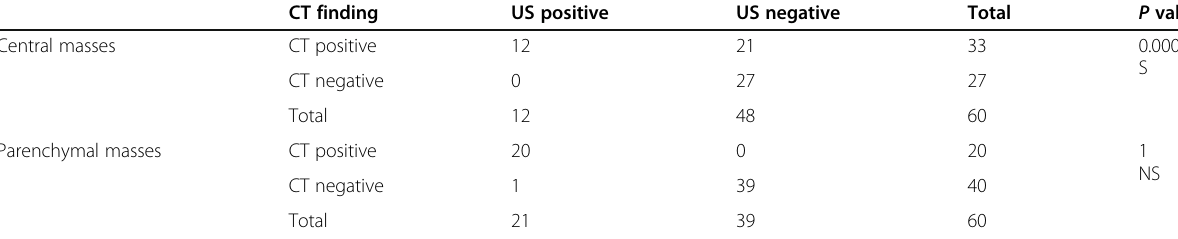
Table 6 Assessment of masses by US in comparison to CT CT finding